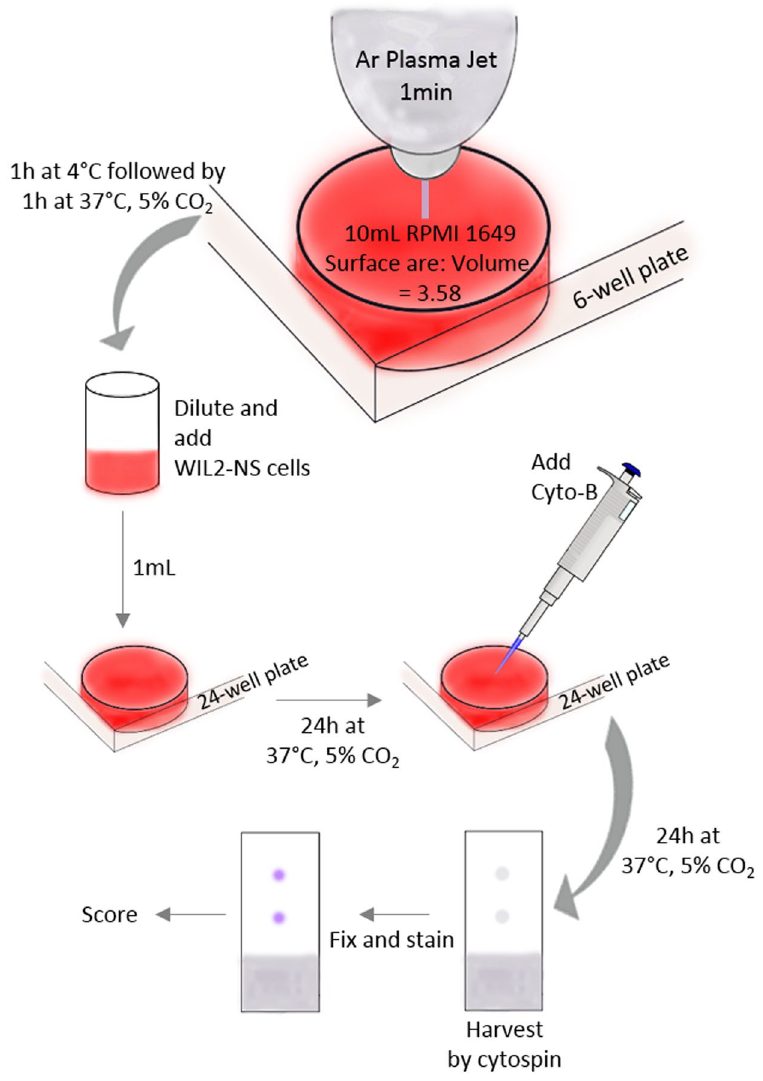
Figure 1. Protocol used to assess the genotoxicity and cytotoxicity of Ar plasma jet-treated RPMI